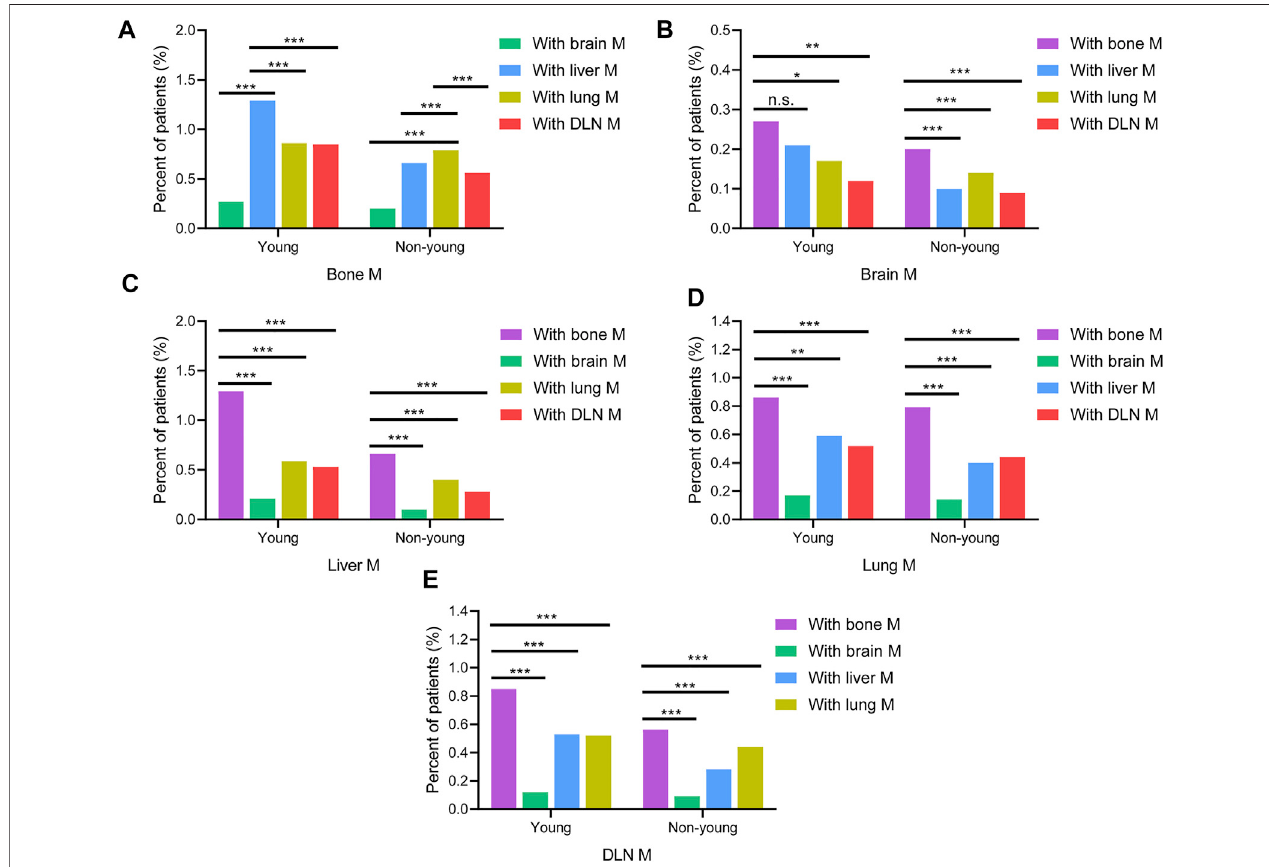
FIGURE4| Comparisonoftheratesofco-metastaticsiteswith (A) boneM, (B) brainM, (C) liverM, (D) lungM, (E) DLNMbetweenyoungandnon-youngcohorts. M, metastasis; DLN, distant lymph node.